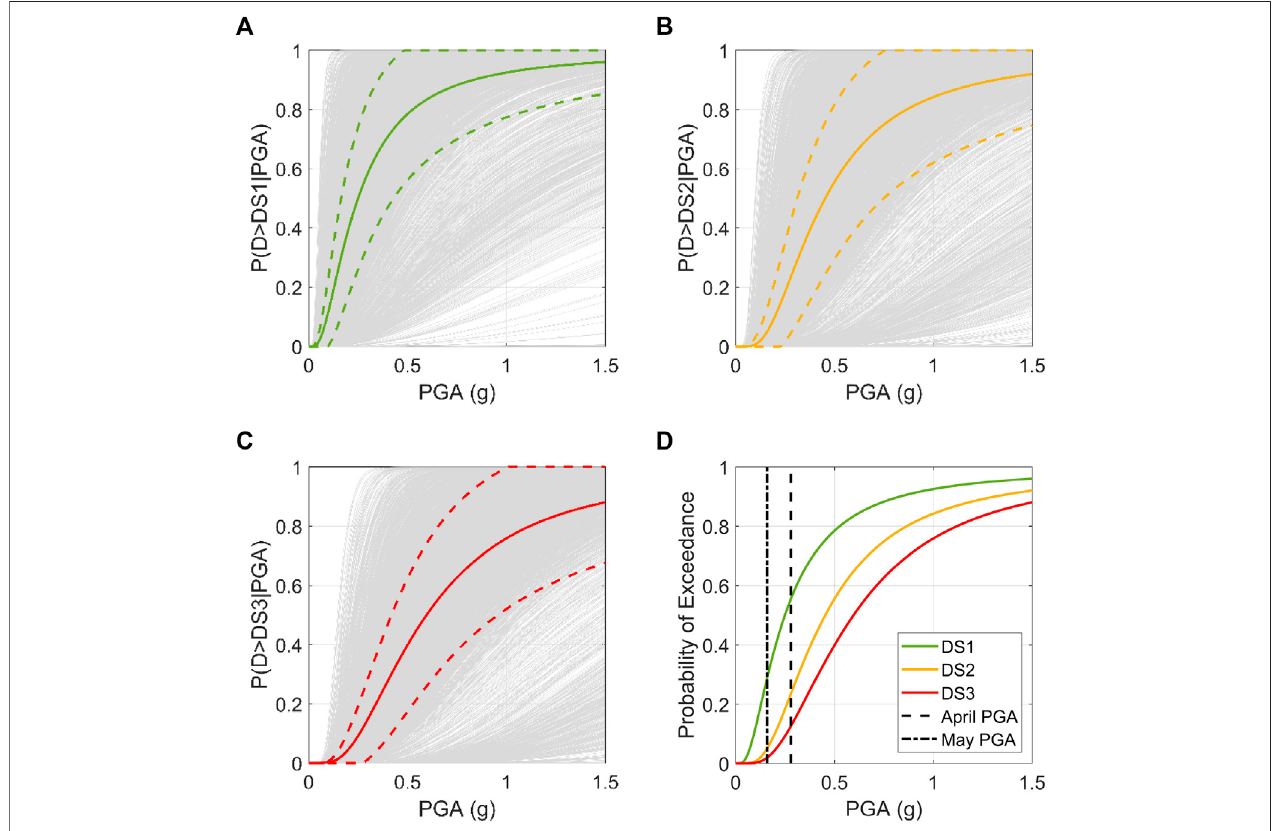
FIGURE 13 | Fragility curves for (A) DS1, (B) DS2, and (C) DS3 associated with the buildings in the Ward-35 database and (D) the comparison of the mean of the class for all the three DSs compared with the maximum PGA as obtained from the shake maps in Figure 9 .